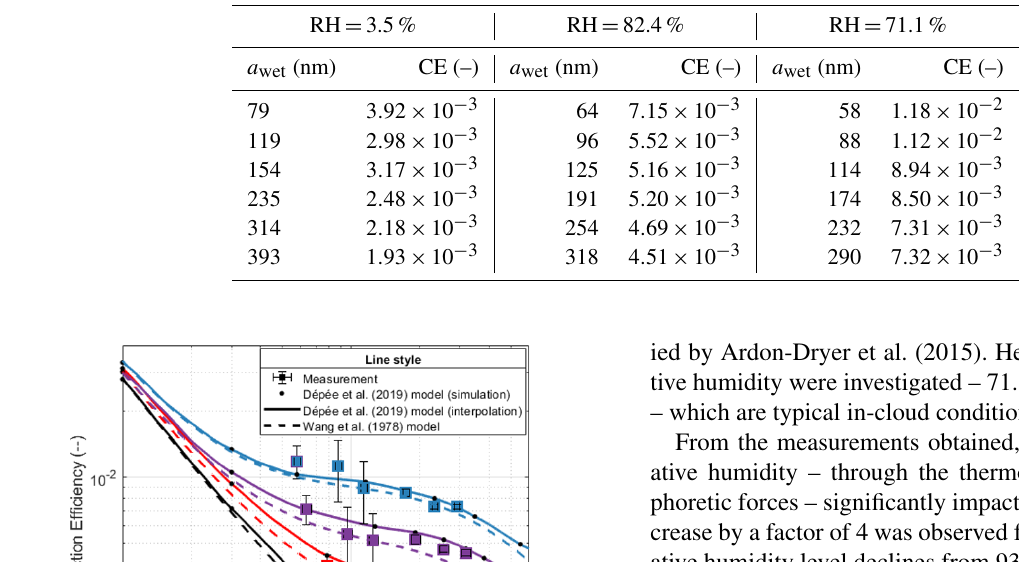
Table 3. CE measurements for the three levels of relative humidity (RH) and the wet AP radii ( a wet ). The droplet radius is 49 . 6 ± 1 . 3µm.